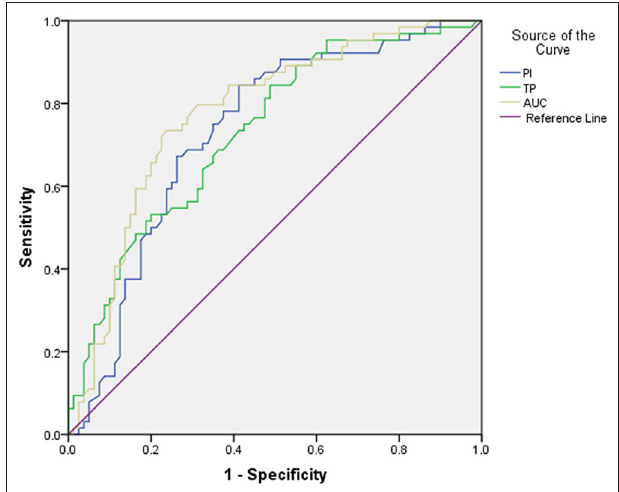
FIGURE 3 | The receiver operating characteristic (ROC) curve for CEUS parameters.